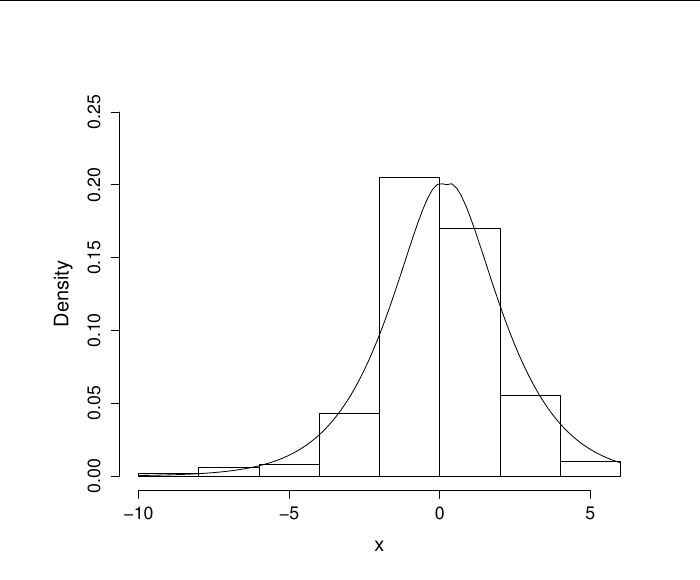
Figure 4 – Fitted Double Lindley distribution for the BPCL data. corresponding p-value (0.10) validate that DLD( θ ) distribution is suitable for fitting the differenced data. Hence we modeled the differenced data using DLDAR(1) (see Figure 4). From the plots of time series, ACF and PACF presented in Figure 5, it is visible that the ACF decays exponentially and PACF is significant at lag 1. Hence we use AR(1) model for this differenced data. The Gaussian estimation method is performed and the values of the parameters are obtained as ˆ a = 0.77 and ˆ θ = 0.18. Akaike information criteria (AIC), Bayesian information criteria (BIC), root mean square error (RMSE) and mean absolute percentage error (MAPE) values are used for the comparison with other models. Comparison of DLDAR(1) with Gaussian AR(1) model is done and the values used for comparison are presented in Table 2. Although the values in Table 2 convey that DLDAR(1) model is equally competitive with the Gaussian AR(1) model, all these selection criteria values are slightly lesser in the DLDAR(1) model than the Gaussian model. Hence we choose DLDAR(1) as a better model. Residual analysis has been con- ducted and prediction of future values has also been done. The ACF and PACF of the residuals are within the limits (see Figure 6) and hence they are random. The predicted values are given in Figure